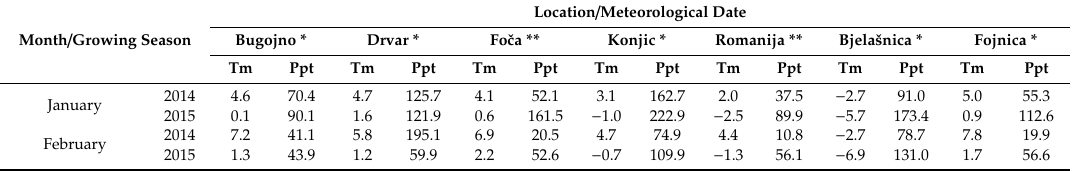
Table 1. Monthly meteorological data for the growing regions in Bosnia and Herzegovina that were